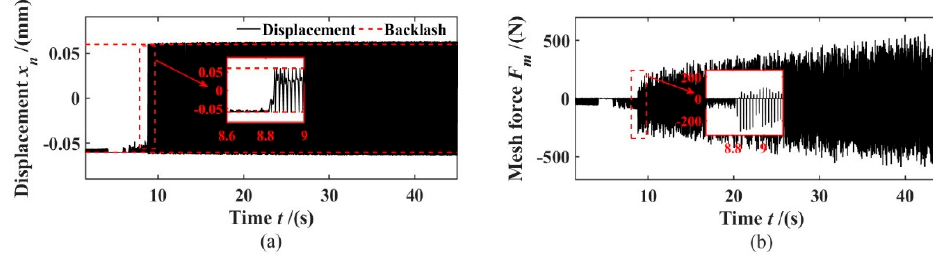
Figure 11. Dynamic response: ( a ) 7th gear relative displacement; ( b ) 7th gear meshing